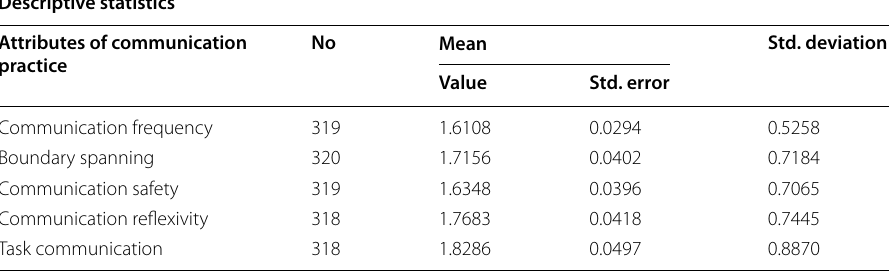
Table 4 Communication practice of craftspeople Descriptive